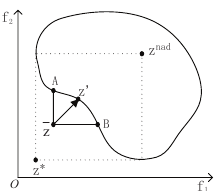
Fig. 1. Behavior of achievement scalarizing